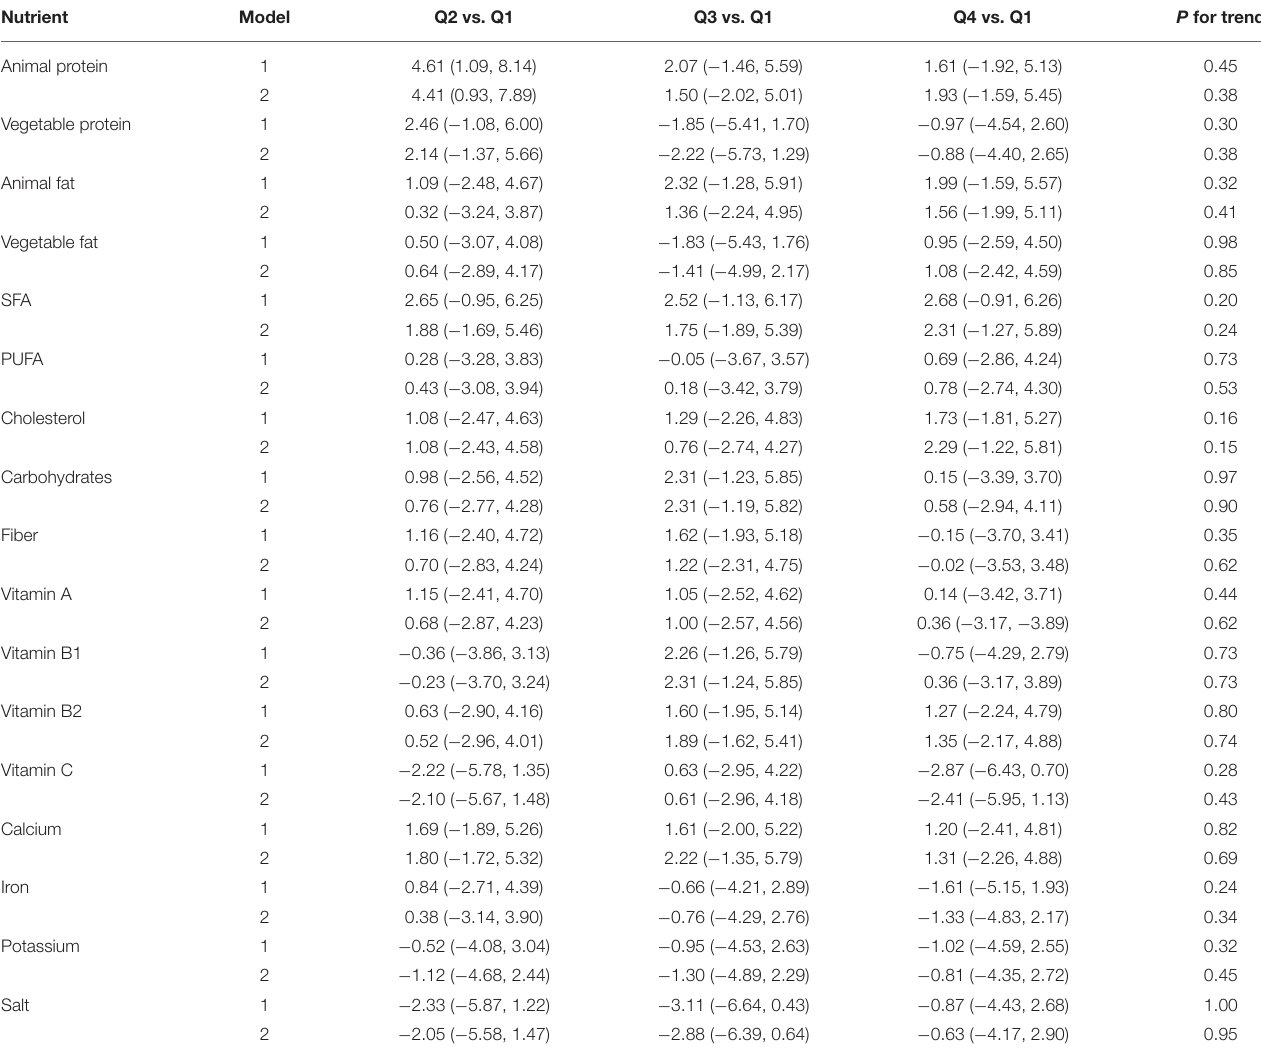
TABLE 4 | Mean CRAE ( µ m) differences across quartiles of energy-adjusted nutrient intake compared with the lowest quartiles. Nutrient Model Q2 vs. Q1 Q3 vs. Q1 Q4 vs. Q1 P for